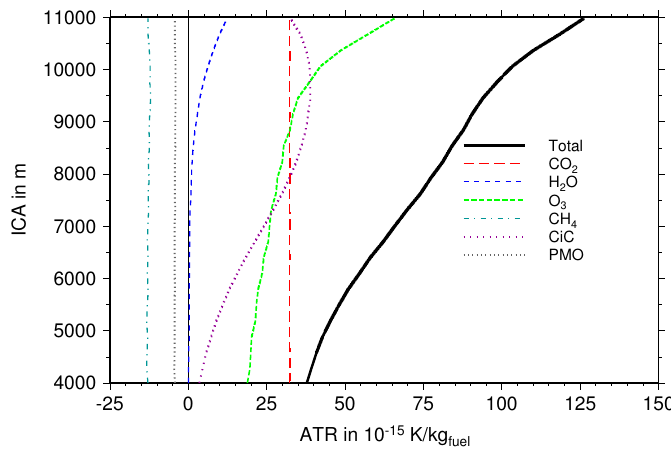
Figure 9. ATR per kg fuel in dependency of ICA for the route DTW-FRA.